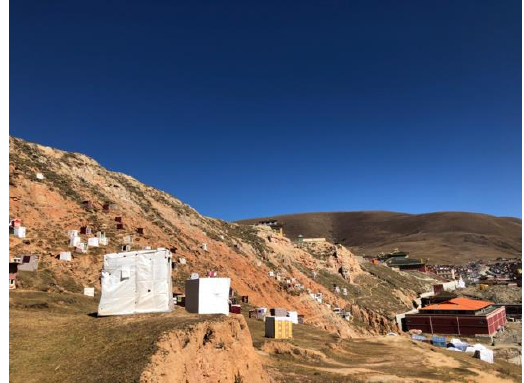
Figure 3. Meditation huts on the hills.